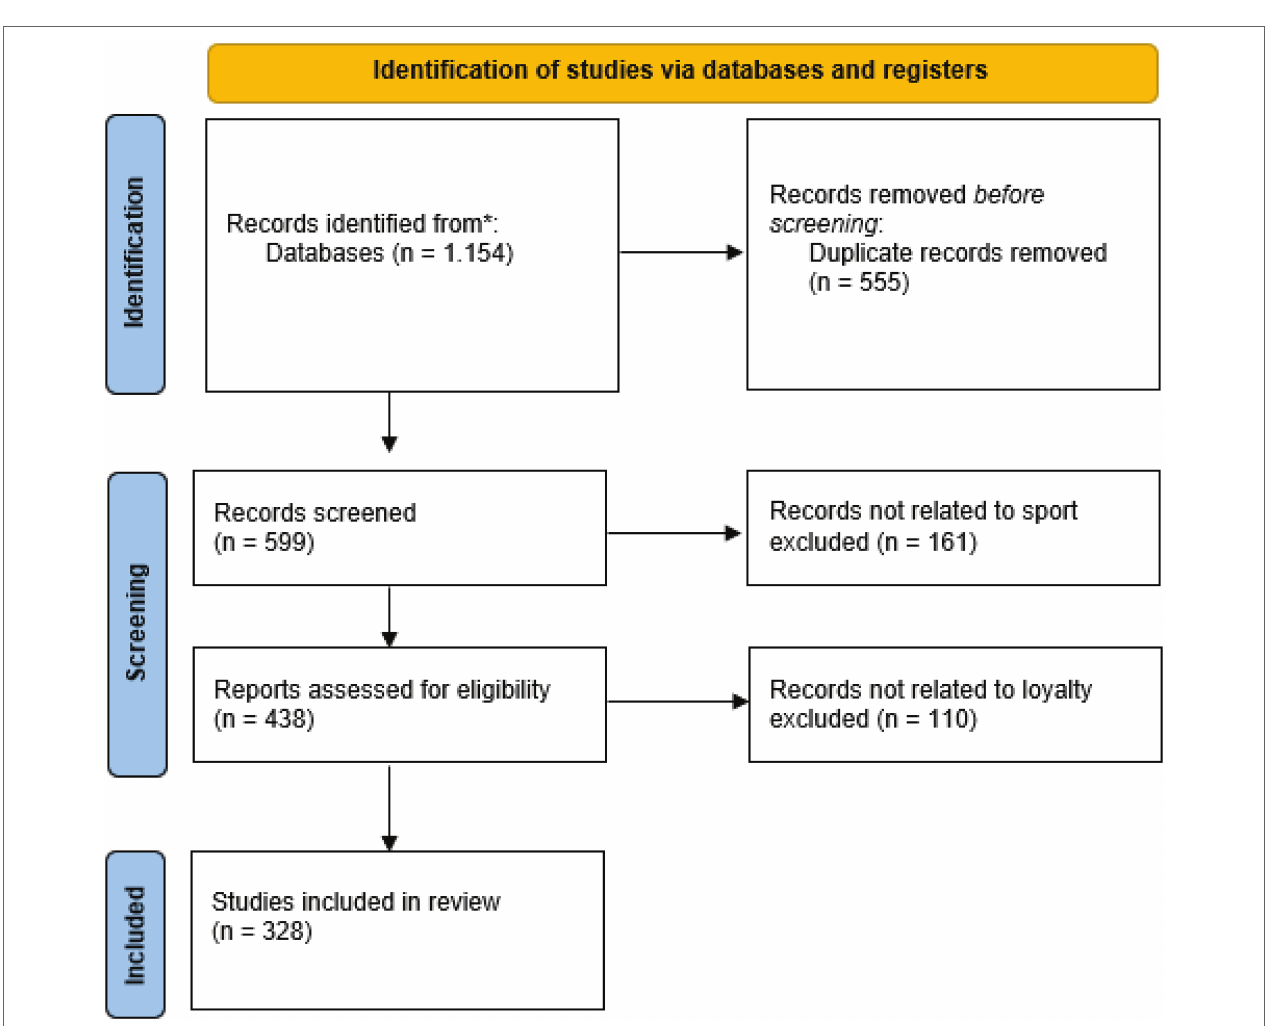
FIGURE 2 | PRISMA 2020 flow diagram for new systematic